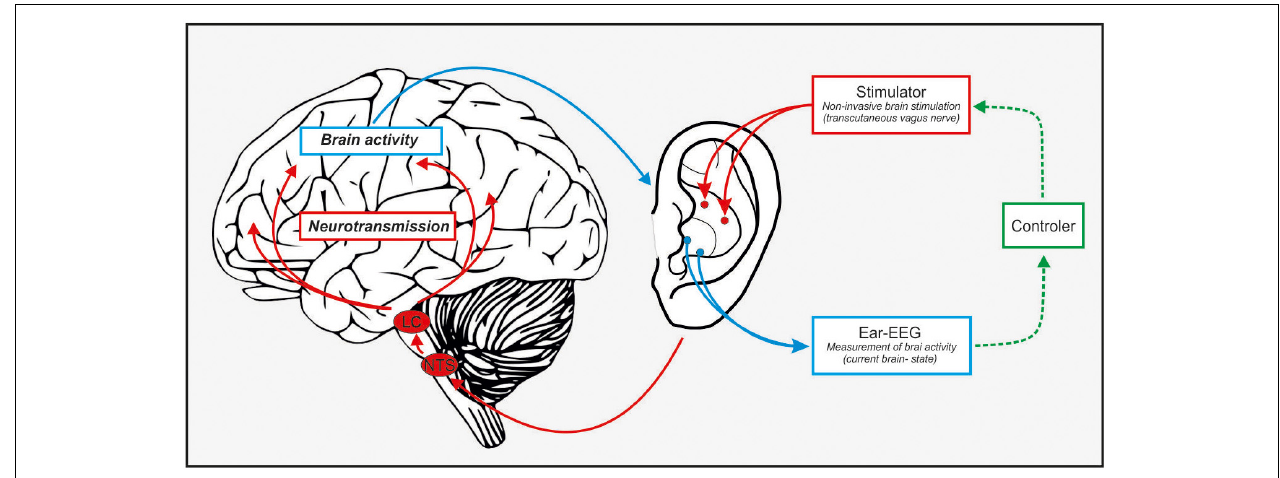
FIGURE 1 | Schematic illustration of a closed-loop in-ear stimulator/recorder. Ear-EEG can pick up on attention markers (alpha oscillations, event-related P300), this information gets fed to a controller that – given a decrease in attention – can start the taVNS which stimulates the NTS-LC system and elevate NE levels. This in turn should result in an increase of attention (or a reduction of the